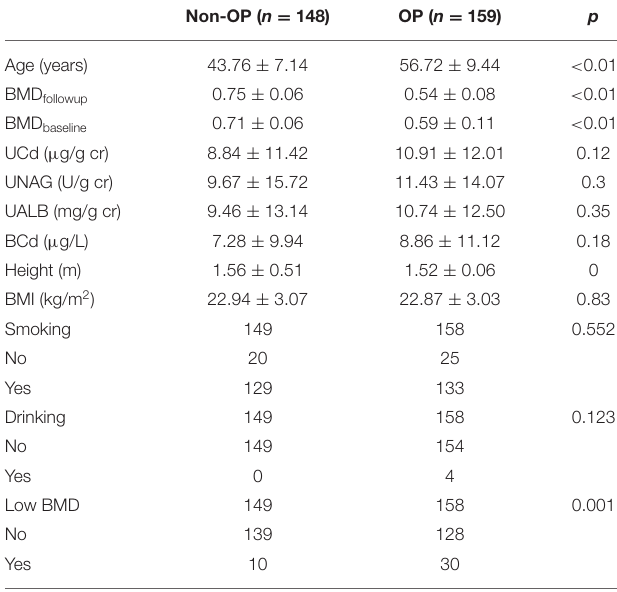
TABLE 1 | The characteristic of subjects with or without osteoporosis